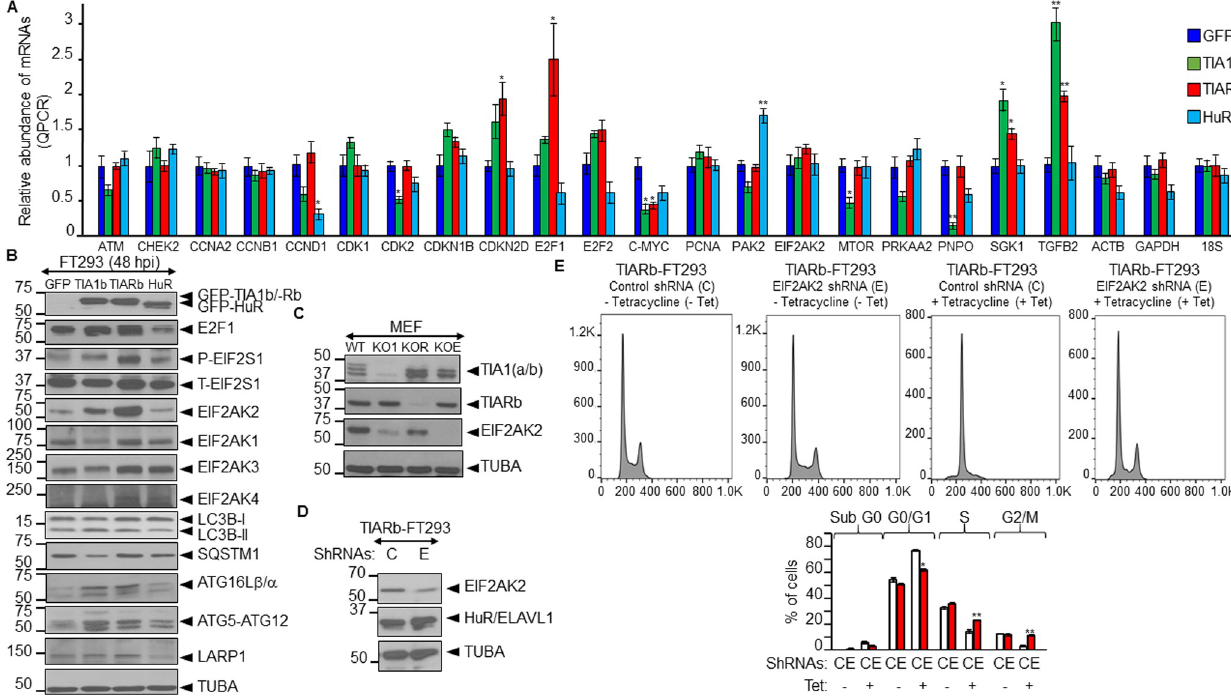
Fig 7. Regulatory crosstalk between the expression of TIA proteins and EIF2AK2-mediated cell quiescence. (A and B) Validation and quantification of relative expression levels of RNAs and proteins by qPCR (A) and western blot (B) analysis. Protein extracts and cytoplasmic RNAs were isolated from GFP-, TIA1b-, TIARb-, and HuR-expressing FT293 cells and analyzed by qPCR (A) and western blotting (B). The represented values were normalized and expressed relative to the GFP control (A). The values are means ± SEM (n = 2–3; � P < 0.05; �� P < 0.01). For western blot analysis were used the antibodies indicated. (C) Effect of the disruption of mouse TIA1, TIAR and EIF2AK2 genes on TIA1, TIAR and EIF2AK2 expression in murine embryonic fibroblasts (MEFs). Protein extracts from normal (WT MEF) or knocked out for TIA1 (KO1 MEF), TIAR (KOR MEF) or EIF2AK2 (KOE MEF) were purified and processed for western blot analysis using the antibodies indicated. (D) EIF2AK2 knockdown using lentiviral particles in TIARb-expressing FT293 cells. Western blot analysis of protein extracts of TIARb-expressing FT293 cells (without tetracycline means in the absence of TIARb expression) stably transfected with shRNAs against control ( C ) and EIF2AK2 ( E ) using a lentiviral transfection. The blot was probed with specific antibodies against EIF2AK2, HuR/ELAVL1 and TUBA proteins. (E) TIARb-expressing FT293 cells transfected with shRNAs against control ( C ) and EIF2AK2 ( E ) were seeded and grown for 3 days in the absence (-) and presence (+) of tetracycline. Above cells were monitored by flow cytometry after propidium iodide staining. The data are means ± SEM of the three independent experiments (n = 3; � P < 0.05; �� P < 0.01). (B-D) Molecular weight markers for protein (kDa) and the identities of protein bands are indicated on the left and right by arrowheads,